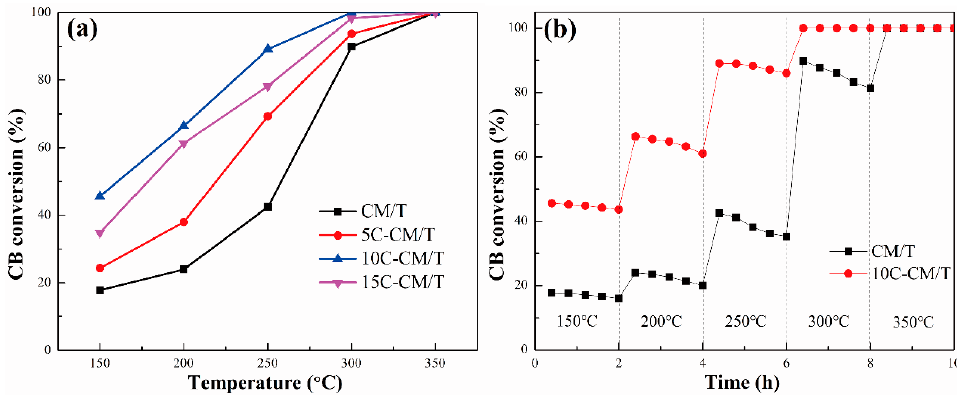
Figure 1. ( a ) CB conversion of CM/T, 5C-CM/T, 10C-CM/T, and 15C-CM/T; ( b ) CB conversion stability of CM/T and 10C-CM/T.